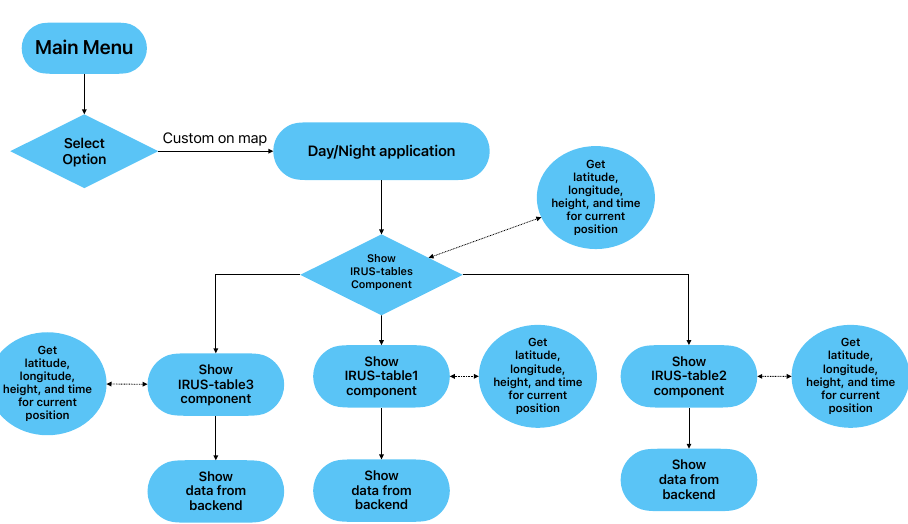
Figure 2. Workflow of the application for day/night menu selection.